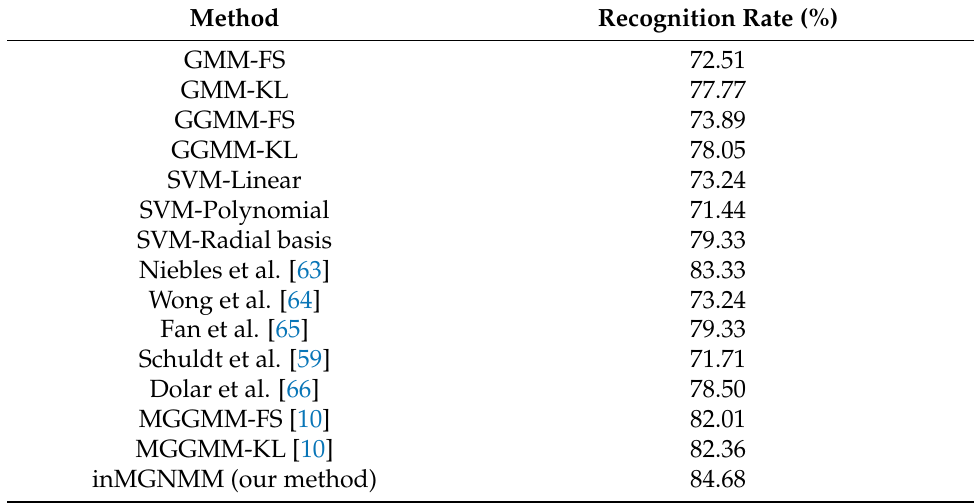
Table 4. Comparative study for Human Activity Recognition between different approaches for the KTH